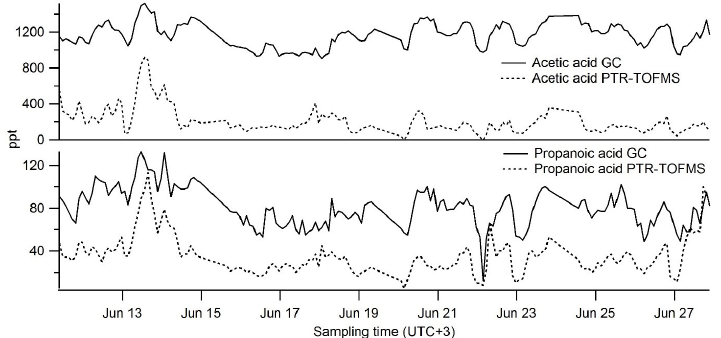
Figure 3. Comparison of mixing ratios (pptv) measured by GC-MS and PTR-TOFMS at SMEAR II in June 2015.